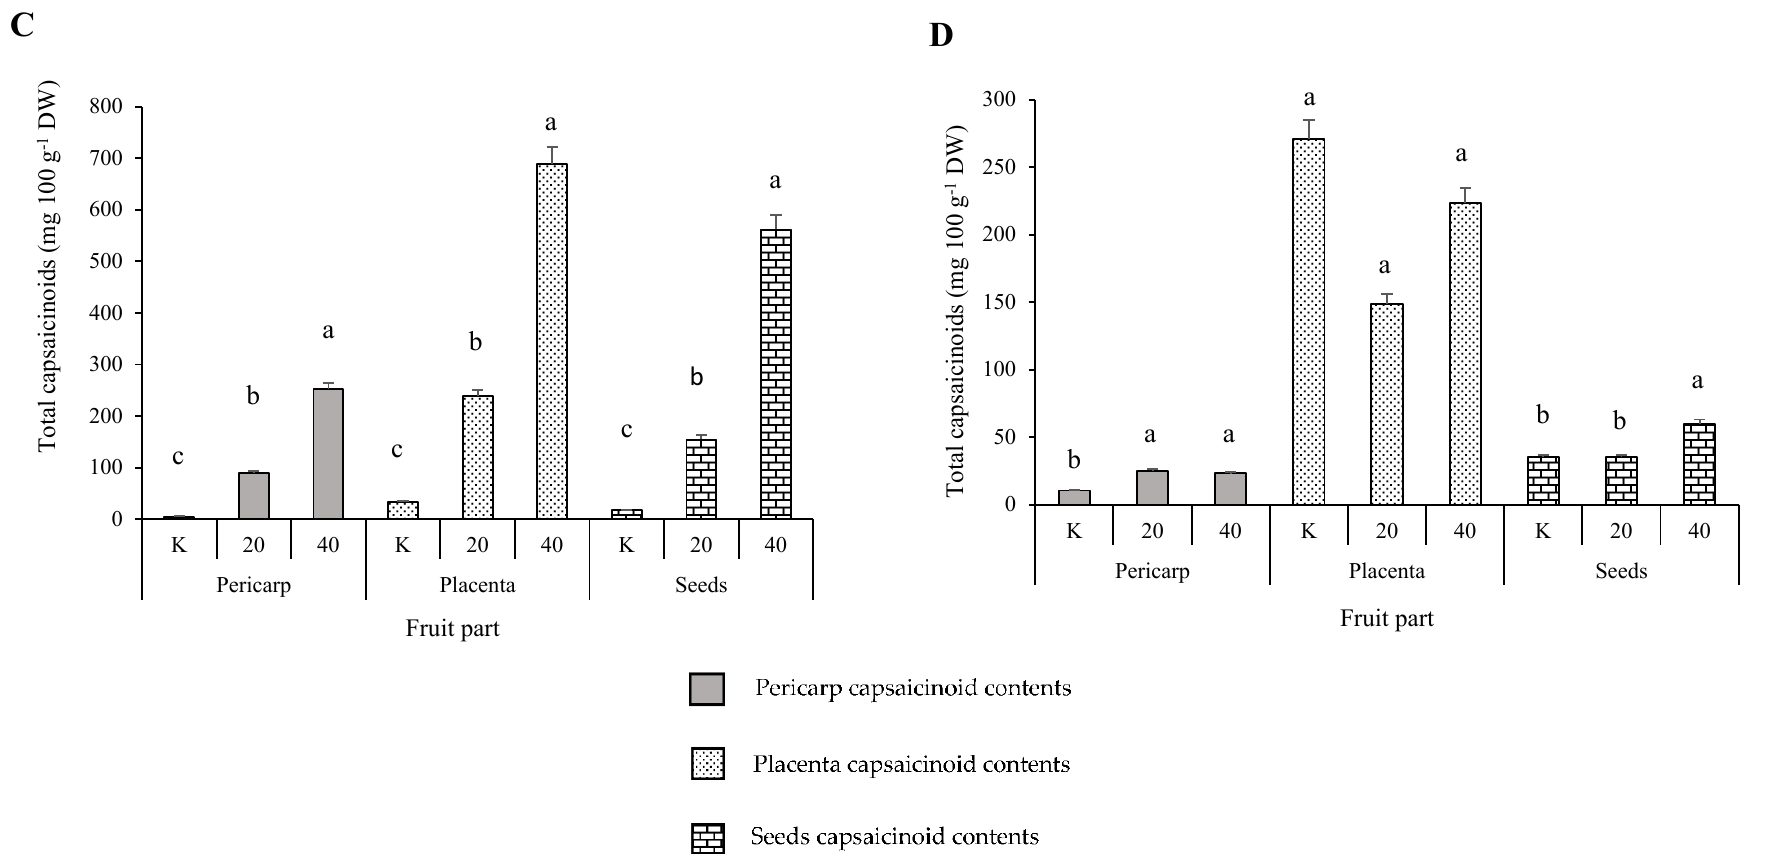
Figure 2. The total analyzed capsaicinoids contents in four salt stressed pepper ( Capsicum annuum L.) cultivars (‘Caro F1’ ( A ); ‘Somborka’ ( B ); ‘Novosadka’ ( C ); ‘Berenyi F1’ ( D )), divided into three fruit parts. a, b, c indicates statistical differences among the NaCl treatments and control. K = control; 20 = 20 mM NaCl; 40 = 40 mM NaCl.